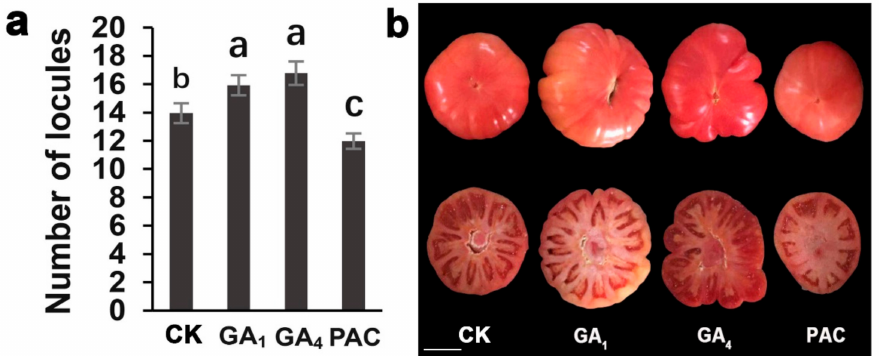
Figure 6. Fruit morphology of application of GA 1 , GA 4 , paclobutrazol (PAC), and H 2 O, as a control. ( a ) Quantification and comparison of locule numbers of GA 1 (100 µ M), GA 4 (100 µ M), PAC (100 µ M), and H 2 O treatments. ( b ) The e ff ect of GA 1 , GA 4 , PAC, and H 2 O treatments on locule number and fruit morphology. The error bars represent the standard errors. Di ff erent lowercase letters represent significant di ff erences ( p < 0.05, Duncan’s multiple range test). Scale bar: 3